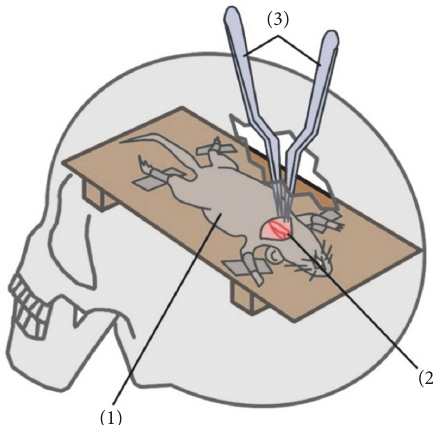
Figure 1: Microsurgical training on rat carotid arteries using an artificial skull with craniotomy as a simulation of surgical approach: (1) rat, (2) rat carotid arteries, and (3) microsurgical instruments.